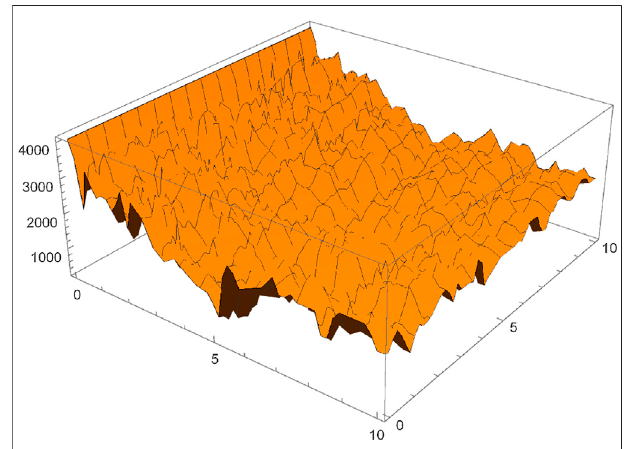
FIGURE 4 | A visualization of the algorithmic cost function, as approximated by coarse BDM, corresponding to the parameter approximation of an ordinary differential Eq. 2 . From the surface obtained we can see the complexity of fi nding the optimal parameters for this problem. Gradient based methods are not optimal for optimizing algorithmic information based